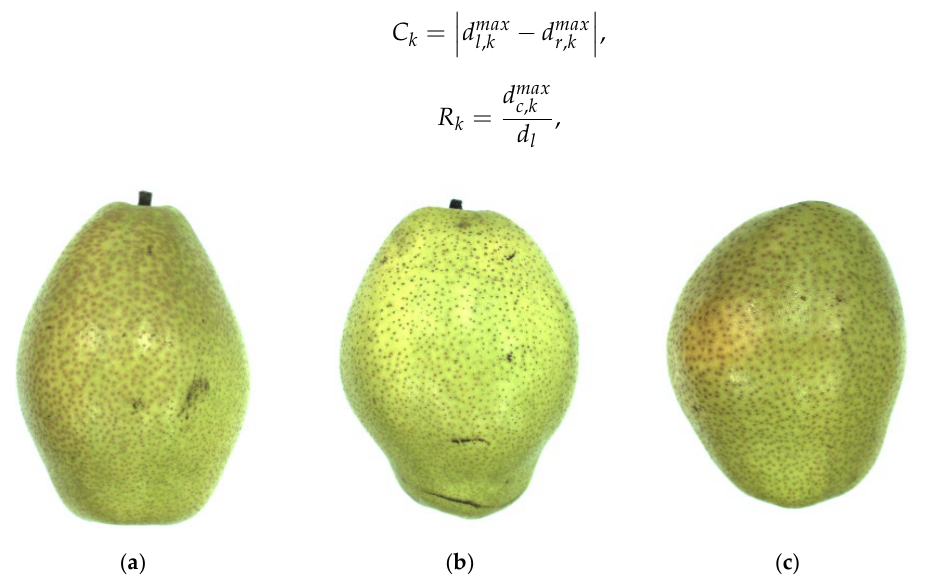
Figure 1. Pear shape. ( a ) Standard shape. ( b ) Apical shape. ( c ) Eccentric shape.